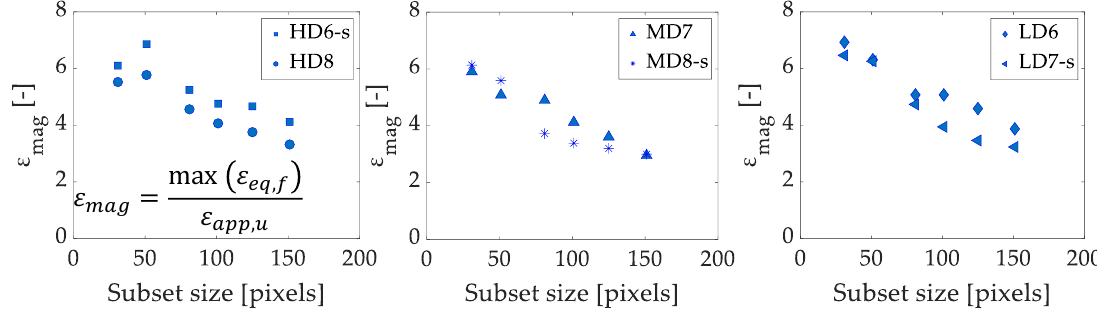
Figure 7. Subset size variation influence on the equivalent strain magnification at the apparent ultimate point for HD ( left ), MD ( middle ) and LD specimens ( right ). The extension -s denotes speckled specimens. Lucas–Kanade displacement tracking algorithm assumes small deformations inside the subset.